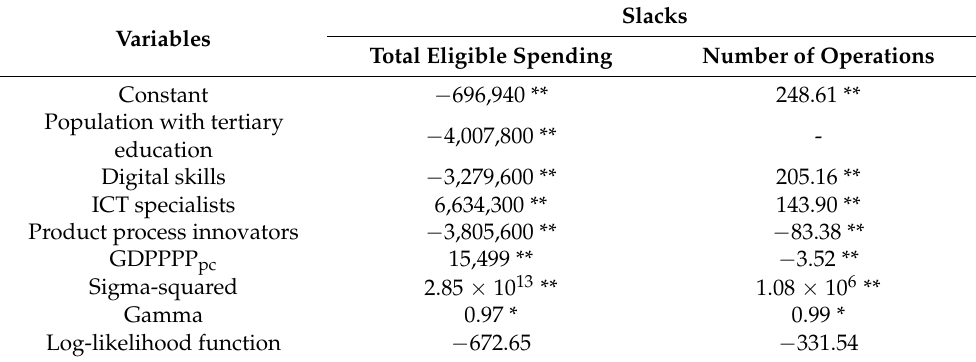
Table 11. Results obtained with SFA regression